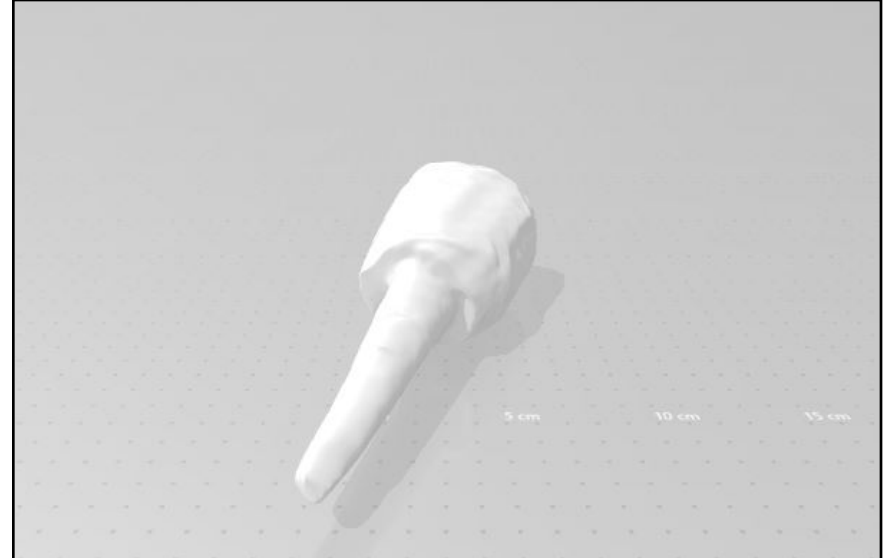
Figure 4. Sample of STL file of the proposed design of the specimen.